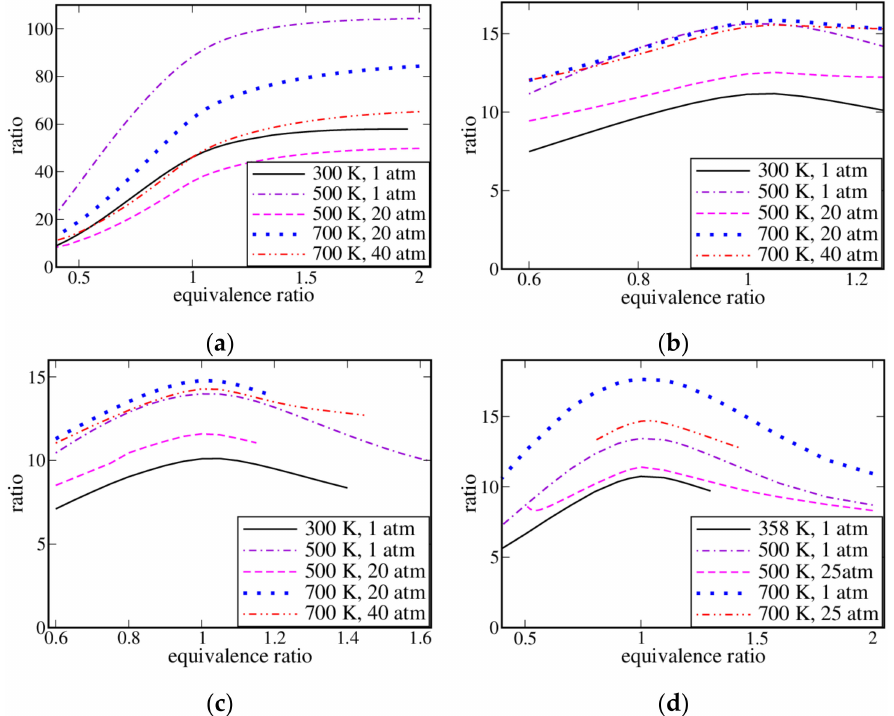
Figure 8. Dependencies of the factor Γ F on the equivalence ratio, calculated for ( a ) H 2 , ( b ) CH 4 , ( c ) C 3 H 8 , and ( d ) n -C7H16, calculated for various pressures P and unburned gas temperatures T u , specified in